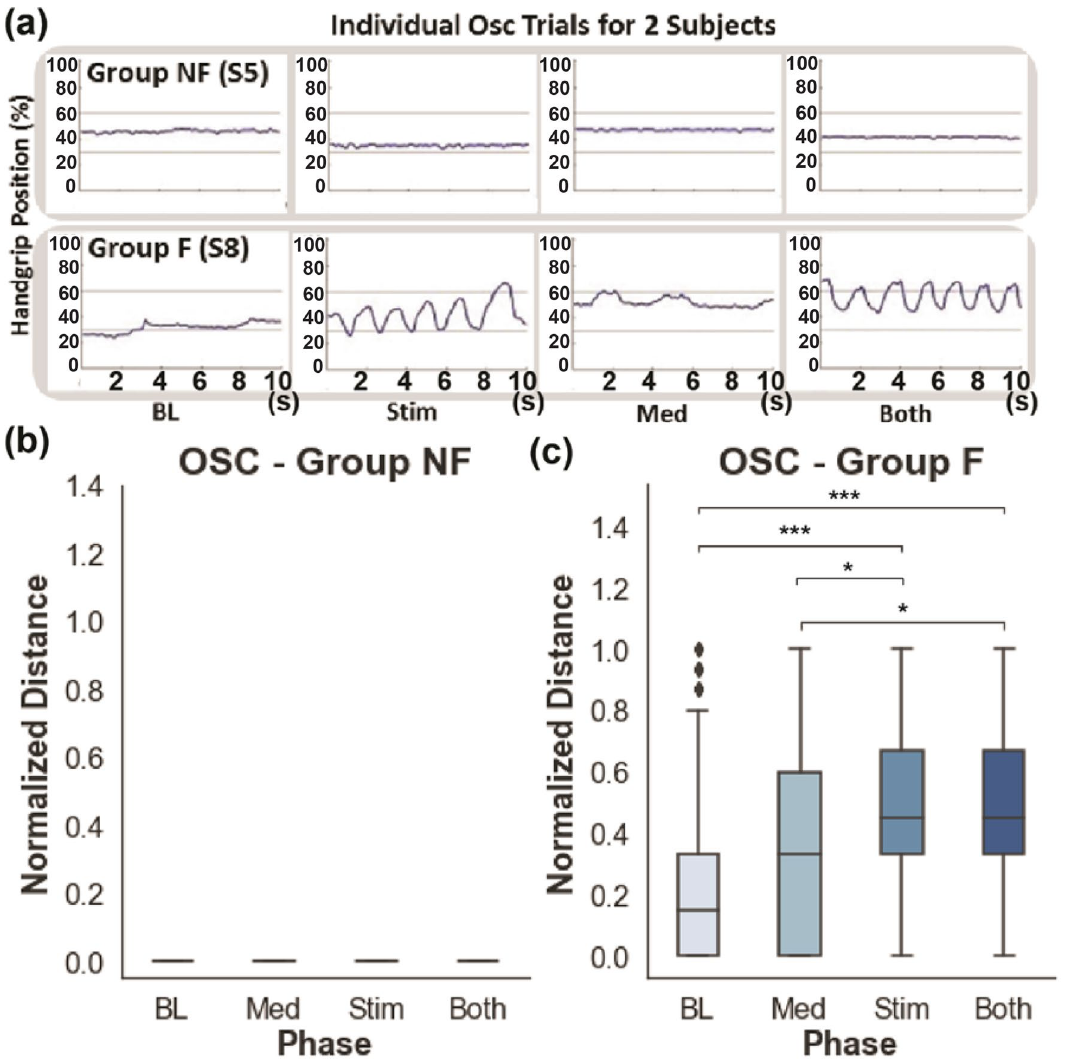
Figure 5. The performance of the OSC test in Group F and NF. ( a ) Representative results of OSC testing from two subjects, one from each group (Group F: S8 and Group NF S5). ( b , c ) Normalized oscillation scores for Group NF and Group F, respectively (n = 5 for each group). The number of asterisks indicates the threshold significance level detected by the two-way ANOVA; *: P < 0.05, **: P < 0.01, and ***: P < 0.001. The means and the standard deviation (SD) are